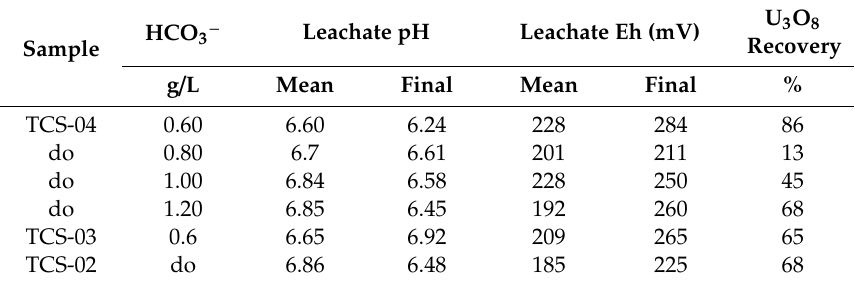
Table 9. pH, Eh, and recovery changes against each of the leaching protocols investigated.